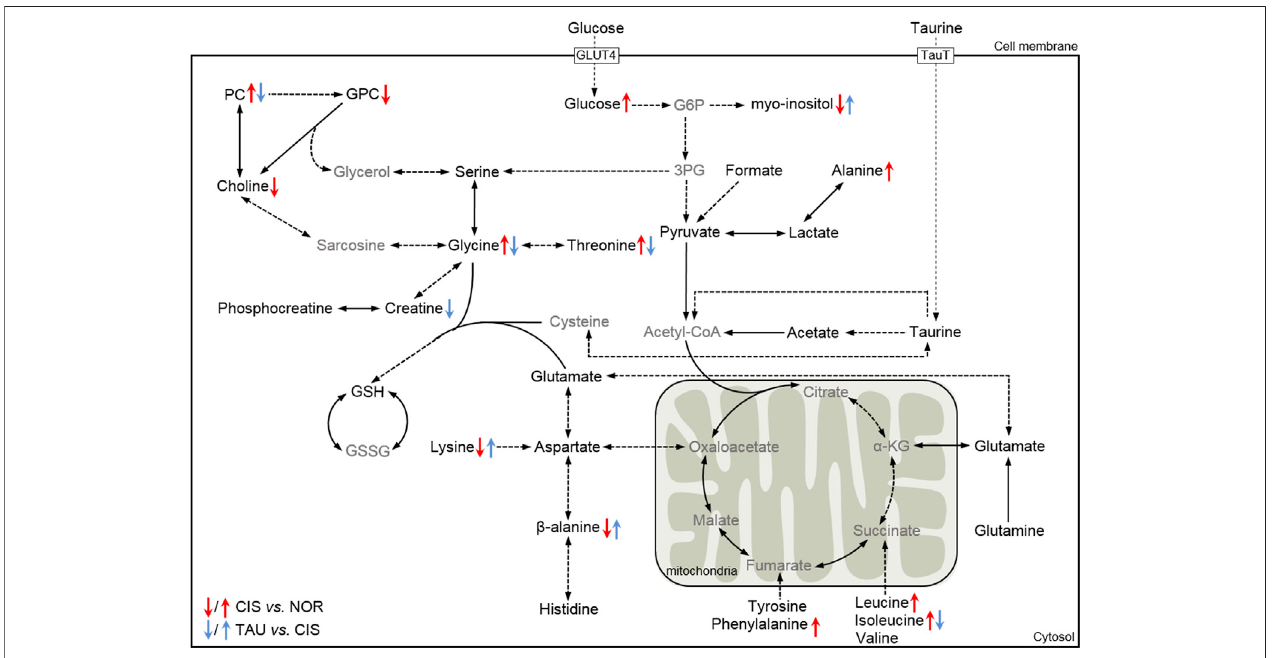
FIGURE 9 | Schematic representation of signi fi cantly altered metabolic pathways of C2C12 myoblasts under cisplatin treatment and taurine supplementation basedontheKEGGdatabase.Dottedarrowindicatesmultiplebiochemicalreactions;solidarrowdenotessinglebiochemicalreaction.Themetabolitesinblack/grayfont refer to detected/undetected metabolites. Abbreviations: GLUT4, glucose transporter 4; TauT, taurine transporter; G6P, glucose-6-phosphate; 3-PG, 3- phosphoglycerate; α -KG, α -ketoglutarate; GSH, reduced glutathione; GSSG; oxidized glutathione.